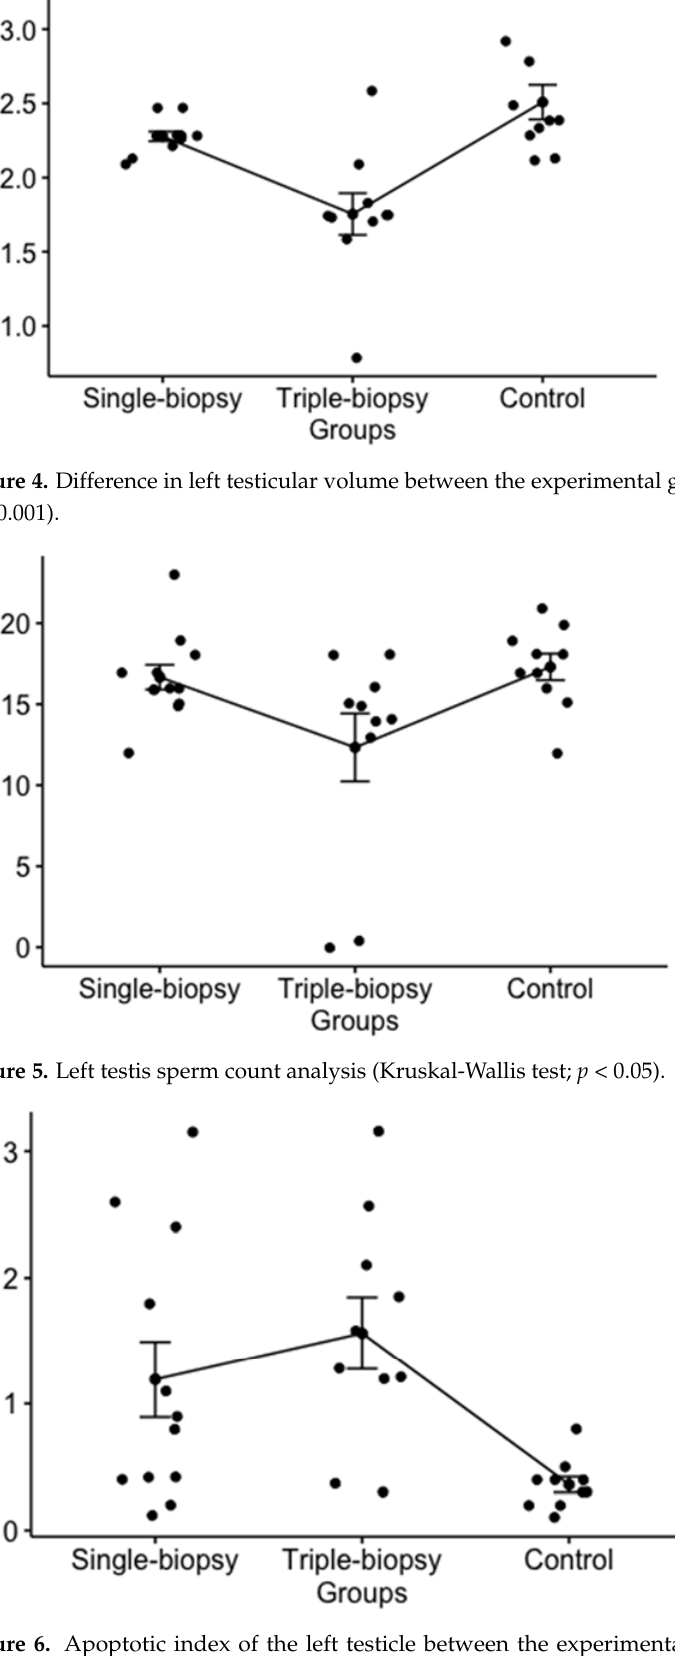
Figure 6. Apoptotic index of the left testicle between the experimental groups (Welch one-way test; p < 0.01). test; p <